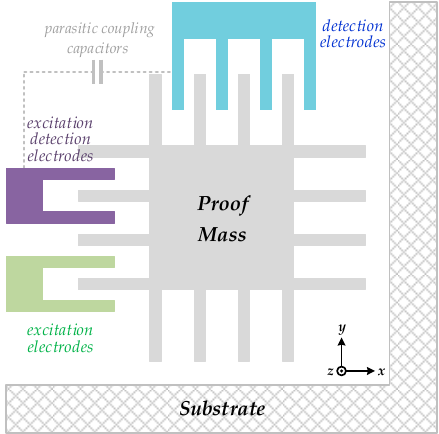
Figure 2. A simplified model of the sense element of MEMS vibratory gyroscopes.